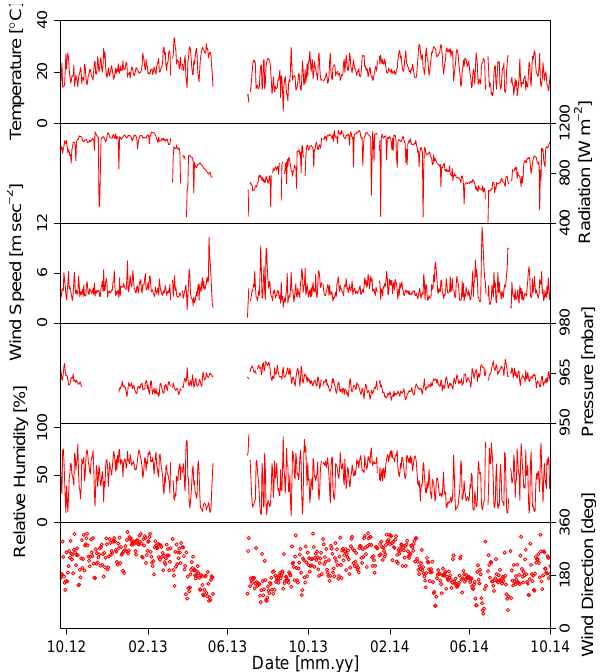
Figure 11. Main time series from NDAO, plotted as daily averages. surement techniques from the field, we do not provide a de- tailed scientific analysis of the data but instead briefly char- acterize the variability of the data with respect to other mea- ment of measurement accuracy.